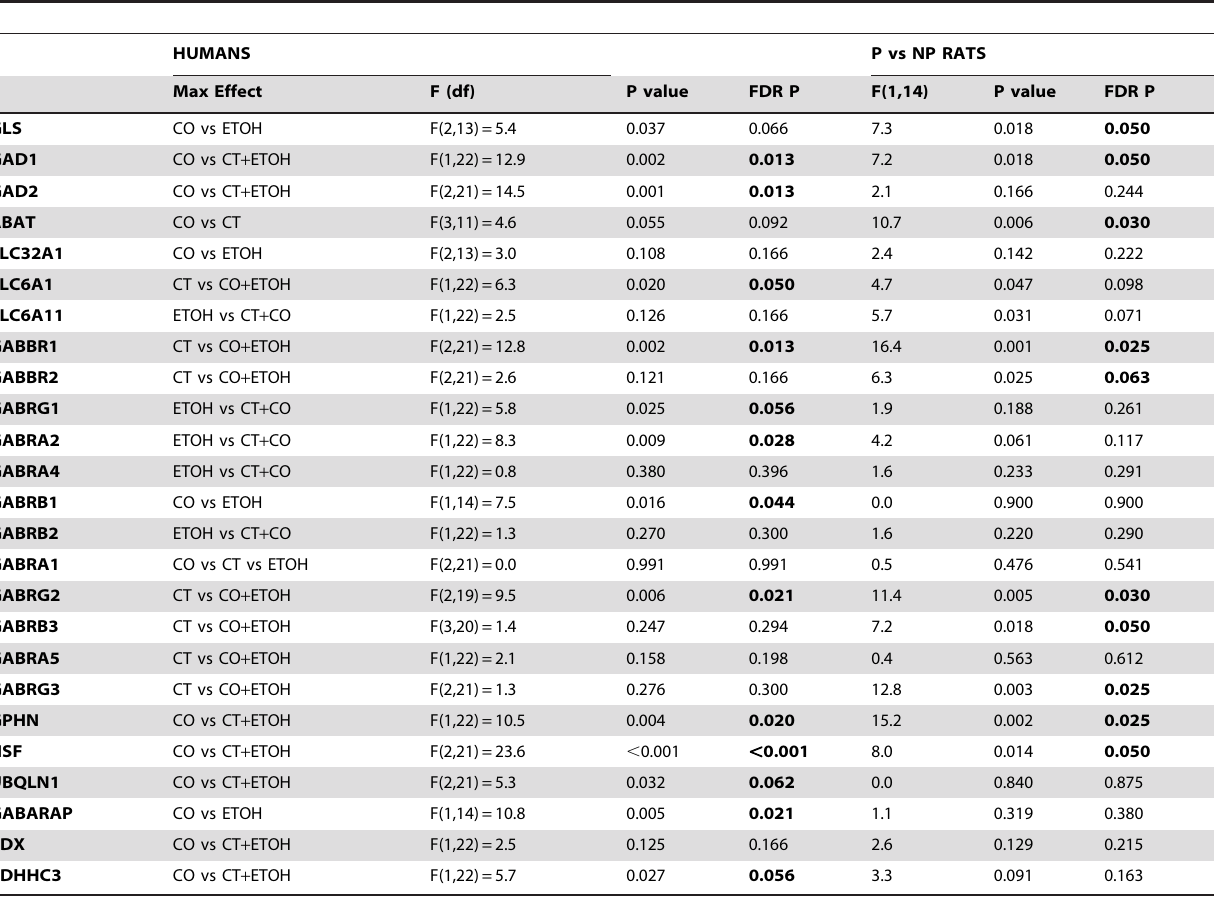
Table 2. Analyses of Gene Expression Changes in Human and Rat Hippocampus.